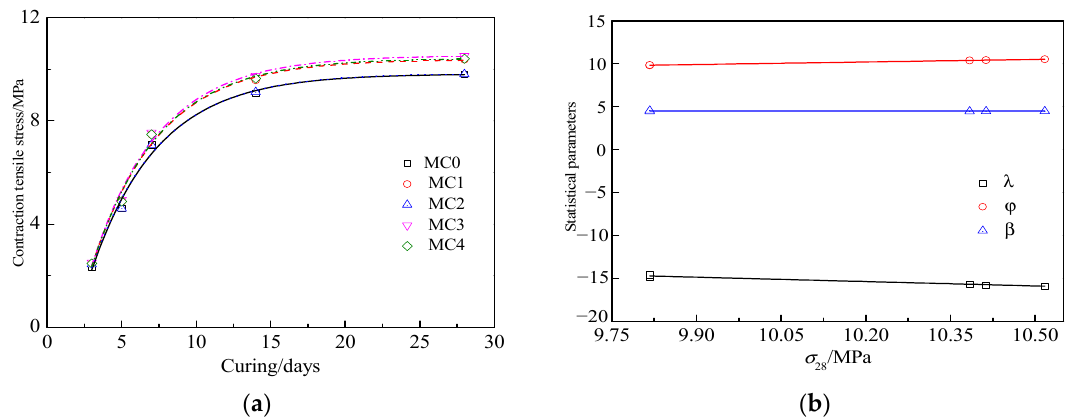
Figure 10. The relationship between contraction tensile stressand statistical parameters and curing age: ( a ) σ ( t ); ( b ) σ 28.